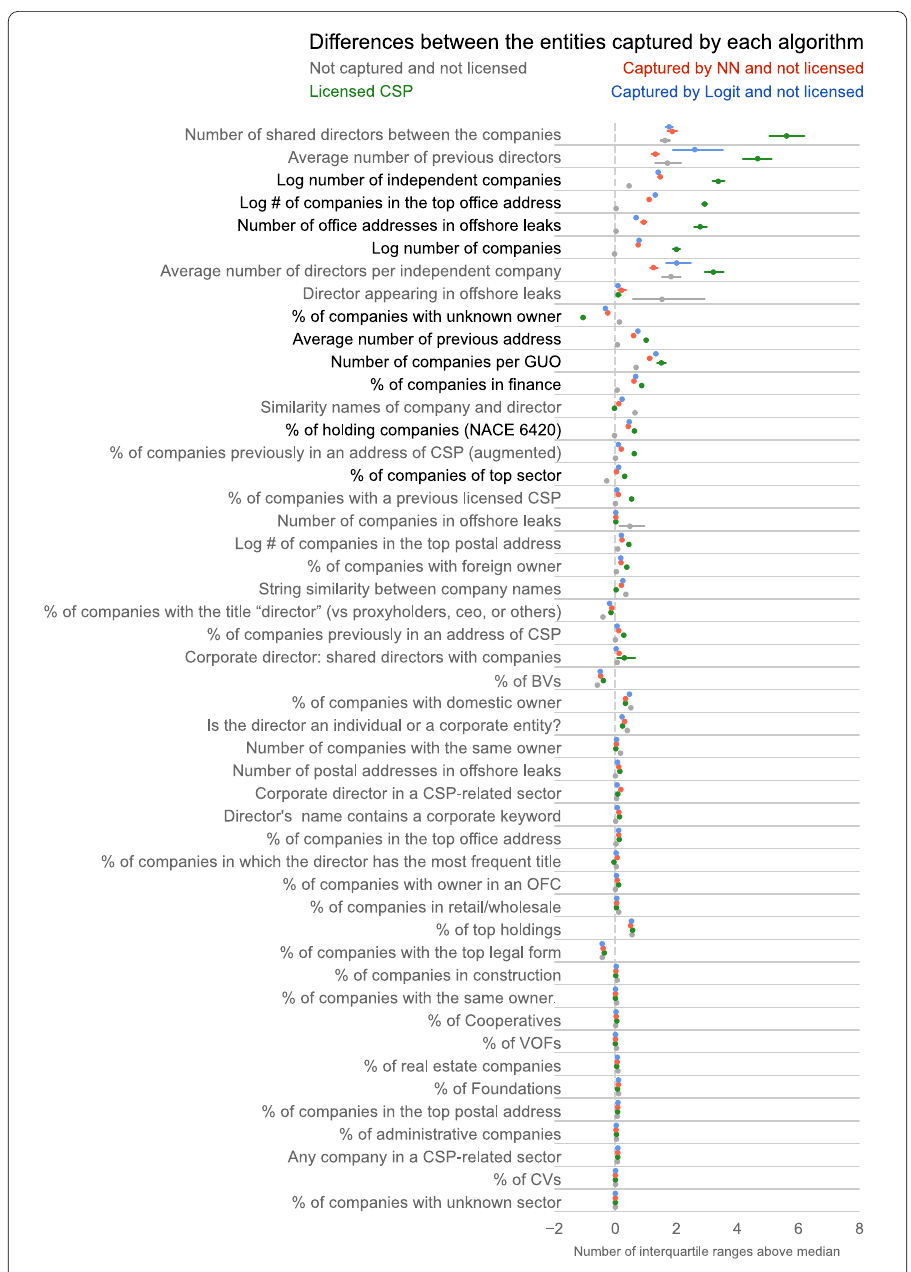
Figure 6 Mean normalized value for each variable, by group: licensed CSPs (green), non-licensed directors captured by the nearest neighbors algorithm (red), non-licensed directors captured by the logistic regression (blue), and non-licensed directors not captured by any algorithm (gray). Variables have been normalized to represent the number of interquartile ranges over the median value. Variables highlighted in black show different values for the flagged directors (red and blue) compared with non-flagged directors (gray). Confidence intervals are found via bootstrapping. See Sects. 3.1 and A.4 for a detailed explanation of the